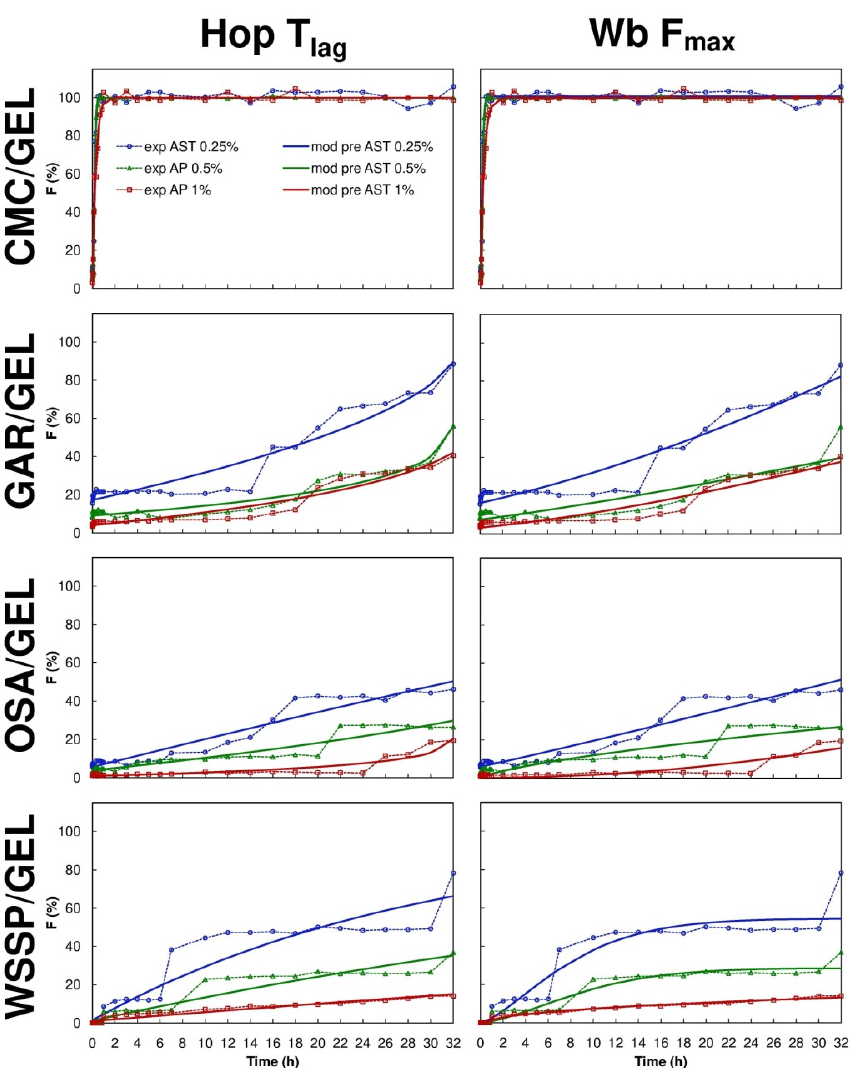
Figure 5. Fraction (F) of AST released from binary polysaccharide/GEL blend films according to the Hopfenberg with T lag ( Hop T lag ) and Weibull with F max ( Wb F max ) models; experimental (exp) and model predicted data (mod pre).